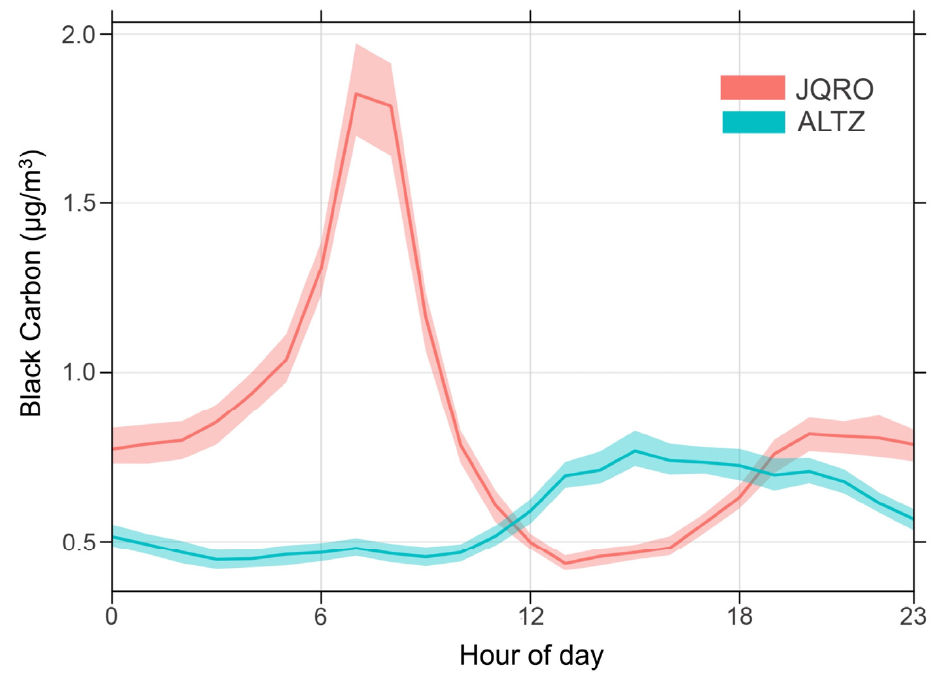
Figure 3. Average daily profile of BC in JQRO and ALTZ for 2017. The shading highlights the standard deviation.